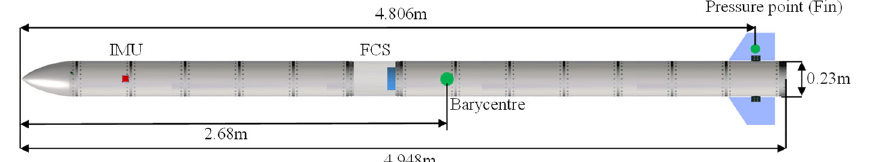
Figure 10. Schematic diagram of the slender vehicle.